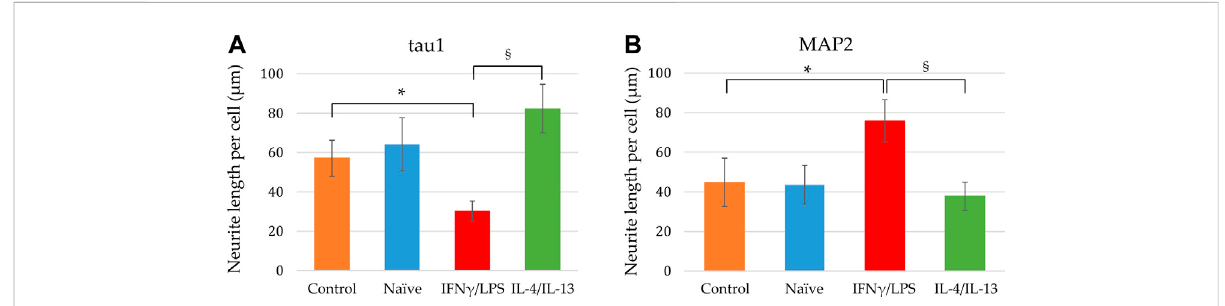
FIGURE 6 Quantitative analysis of axonal and dendritic development of differentiating neuronal cells exposed to naïve and stimulated microglia. Using confocal images similar to that shown in Figures 4, 5, the tau1-positive (A) as well as MAP2-positive (B) neurite lengths per cell were calculated from the corresponding total neurite lengths and the cell numbers. Data are presented as mean ± SEM calculated from two biological parallels (each conditions include 1000 – 2500 cells). For statistical analysis, Mann-Whitney U test was performed. Asterisks indicate signi fi cant differences as compared to control (NPCs with no co-culturing), whereas section signs mark signi fi cant differences between neuronal cells co-cultured with pro- and anti-in fl ammatory stimulated microglia ( p <